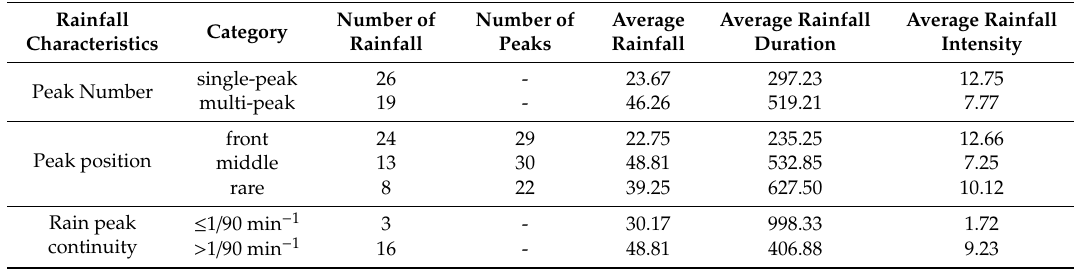
Table 1. Statistics of the rainfall peak